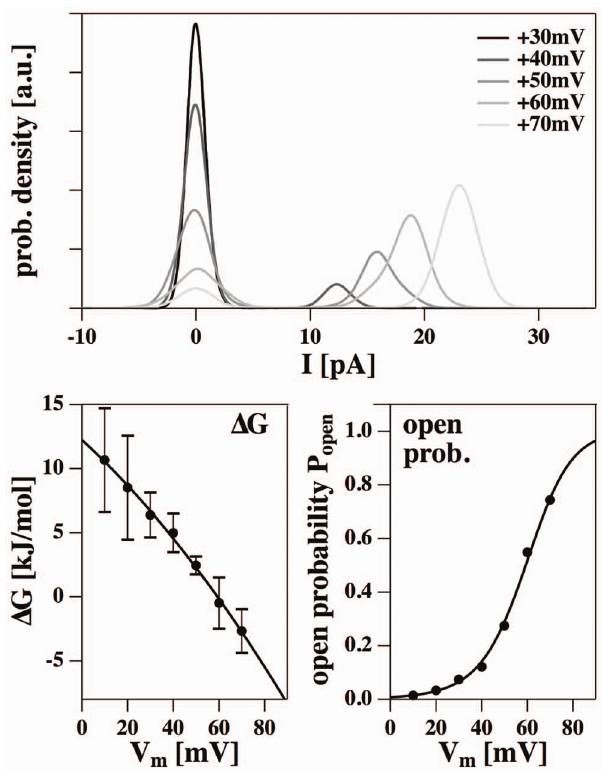
Figure 4. Statistical analysis of the data in Fig. 4. Top: Experimental probability distribution for channel opening at five voltages (cf. Fig. 4). Bottom, left: The calculated free energy difference between open and closed state as a function of voltage indicates a quadratic voltage dependence (see eq. 4, D G 0 = 21.3 kJ/mol; a = 2 721 kJ/mol : V 2 , V 0 = 2 110 mV). Bottom, right: The open probabil- ity, P open , shows a transition at * 60 mV.